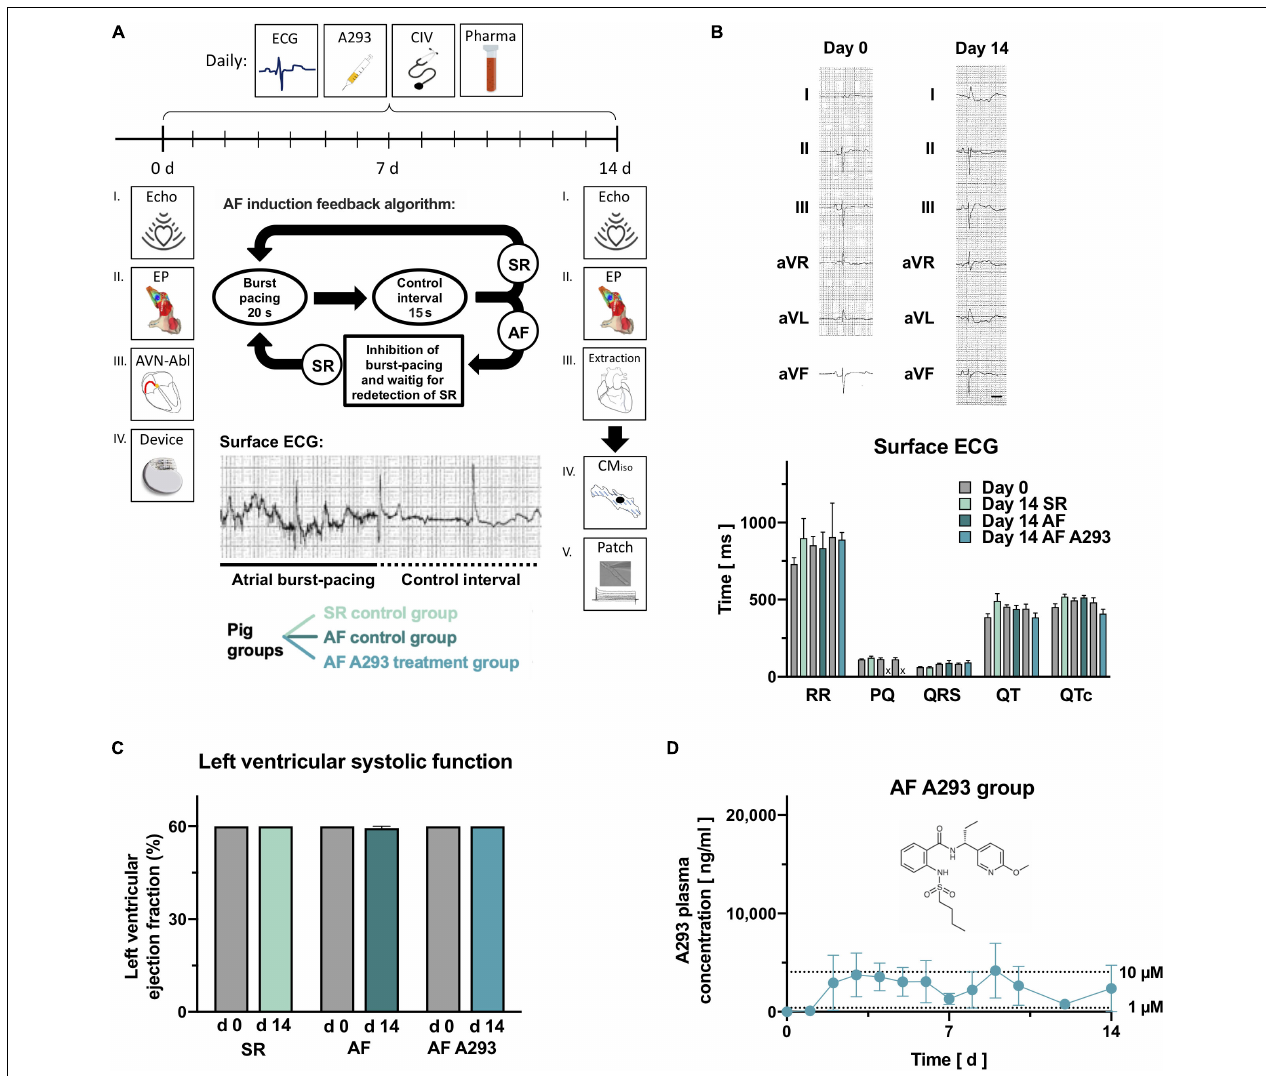
FIGURE 1 | Experimental protocol, surface electrocardiograms and echocardiography parameters. (A) Subsequent to an electrophysiological (EP) investigation and pacemaker (device) implantation, n = 15 pigs were randomized to atrial fibrillation (AF) induction or a sinus rhythm (SR) control group ( n = 5). Pigs randomized to the AF group received AV-node ablations to prevent development of tachycardia-induced heart failure. The AF group was divided into subgroups receiving i.v. sham (NaCl 0.9%; n = 5) or A293 treatment (1 mg/kg bodyweight per day; n = 5). During the 14 days treatment period, pigs received daily sham or A293 treatments, and electrocardiogram (ECG) recordings and clinical investigations (CIV) were performed, and blood samples were taken. At the end of the observation period, electrophysiological investigations were repeated and atrial cardiomyocytes were subjected to patch clamp measurements. The protocol of burst-pacing, applied by the implanted pacemakers is visualized as insert. (B) Representative surface ECG measurements, recorded in a SR control pig at days 0 and 14, are shown in the upper part. No significant differences were observed between the 3 groups when comparing RR and PQ intervals, QRS durations, QT and QTc intervals at day 0 and day 14 with Wilcoxon matched pairs single rank tests. No PQ intervals could be measured in animals which underwent AV node ablation. (C) Values of left ventricular ejection fraction, quantified with echocardiography at day 0 and day 14 did not change significantly (means of n = 4–5 animals; error bars, SEM; scale bar, 200 ms). (D) Plasma levels of A293 (trough levels) during the 14 days period, measured by mass spectrometry. The chemical structure of A293 is provided as insert. Please note that blood clots in central vein catheters caused a relevant loss of follow up at some time points (means of n = 1–5 animals; error bars,